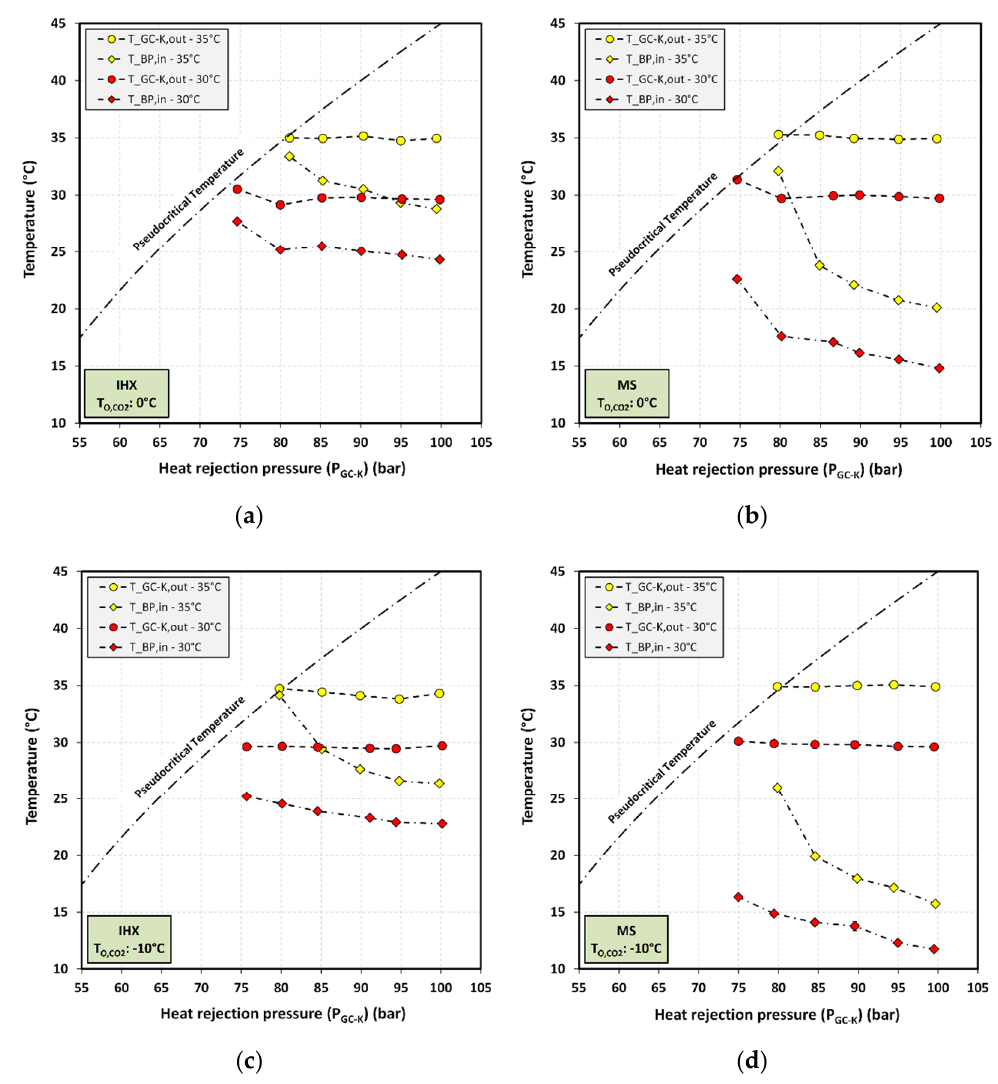
Figure 7. Trends for T BP,in and T GC − K.out with the heat rejection pressure (P GC − K ) at 0 ◦ C with IHX ( a ) and MS system ( b ), and at − 10 ◦ C with IHX ( c ) and MS system ( d ).